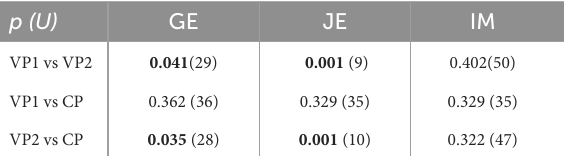
TABLE 3 Statistical significance p (with U -value in brackets) for the sets with Mann–Whitney U -test